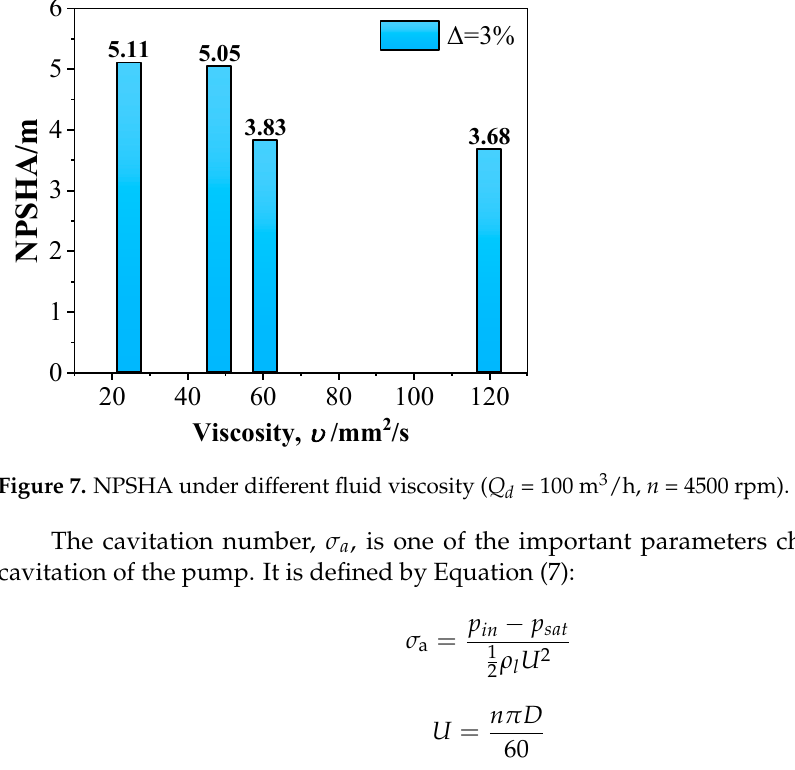
Figure 6. Cavitation characteristic curve of the HAMP under different fluid viscosities ( Q d = 100 m 3 /h, n = 4500 rpm).